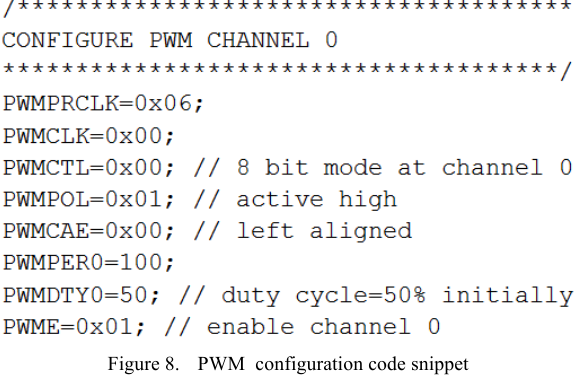
Figure 8. PWM configuration code snippet